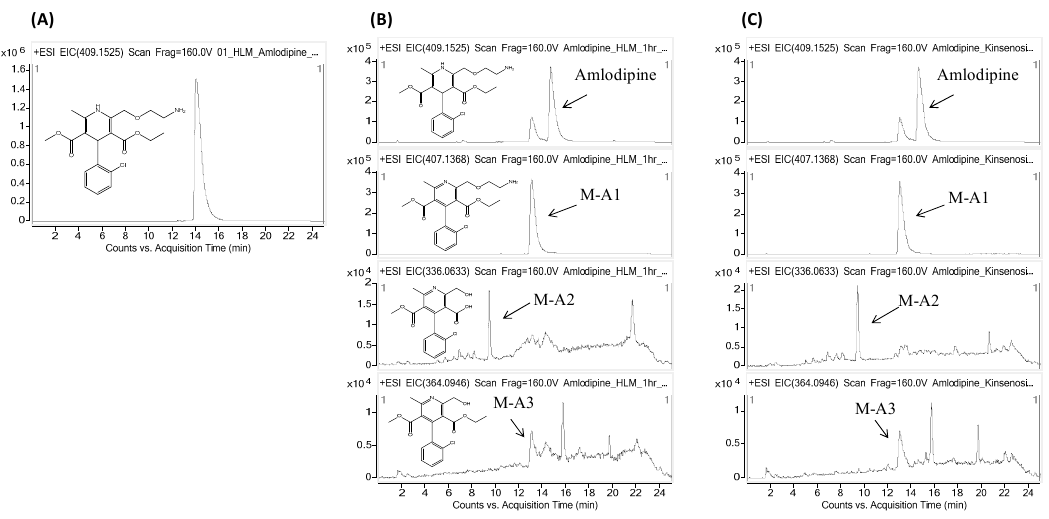
Figure 3. Representative EIC chromatograms for ( A ) amlodipine standard, and in human liver microsome samples ( B ) without kinsenoside (control) and ( C ) with kinsenoside.